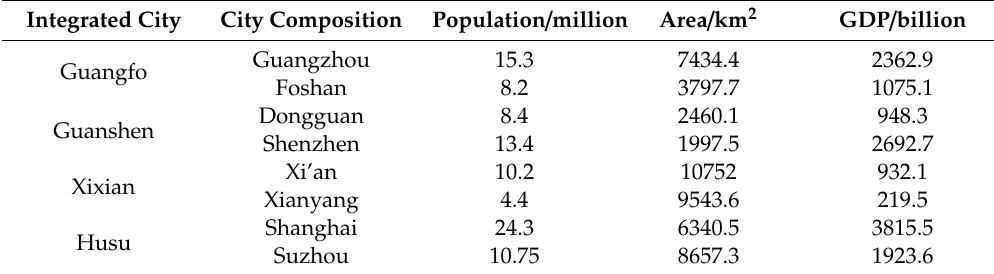
Table 1. Basic statistic information of sample integrated cities.